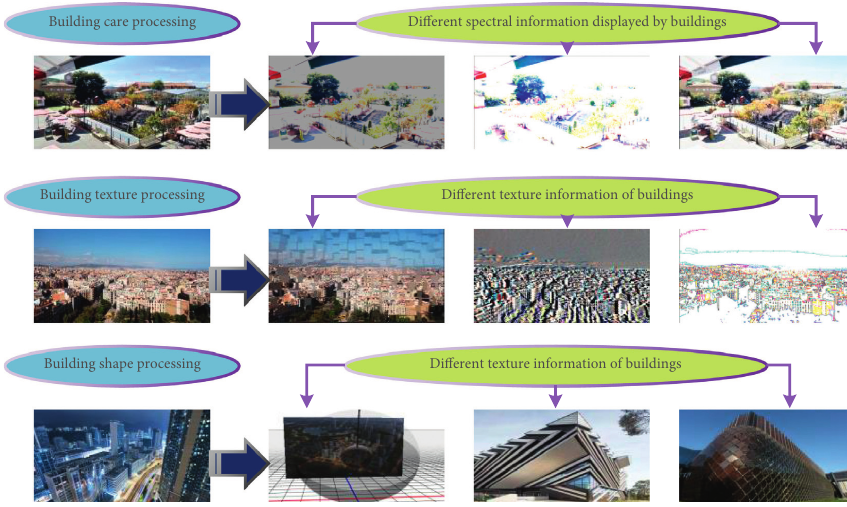
Figure 1: Information on the characteristics of the